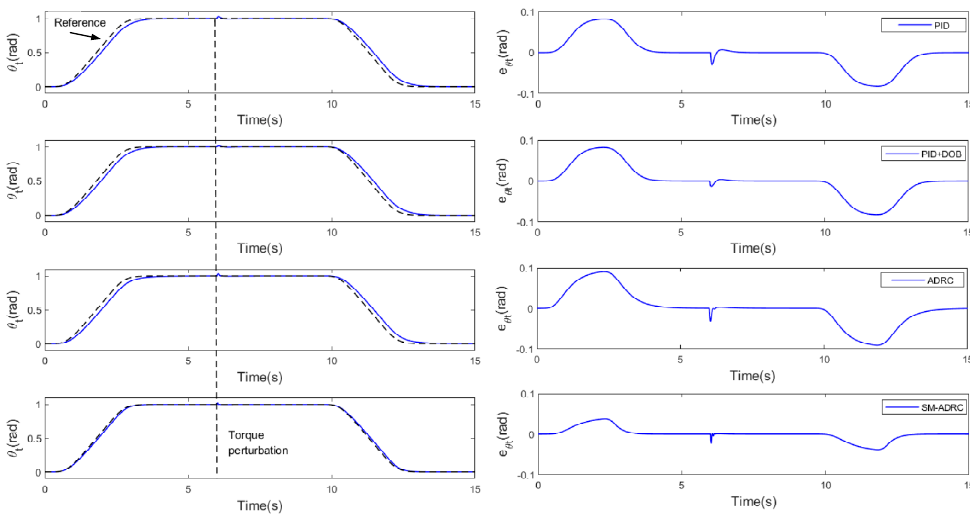
Figure 3. Simulation results of tracking trajectory of the flexible manipulator tip position. Table 3. Index integral absolute error.